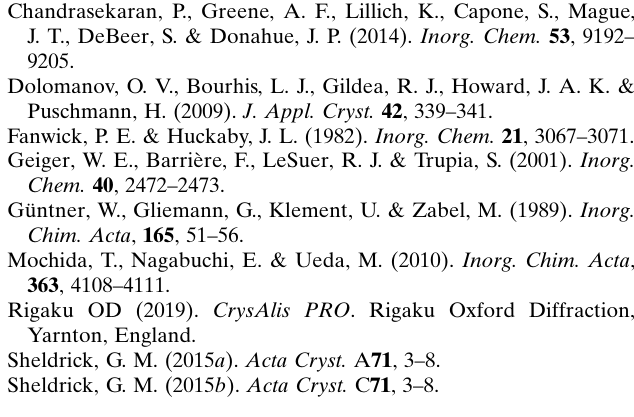
, (cid:2) z + 1 ; (ii) x , 2 2